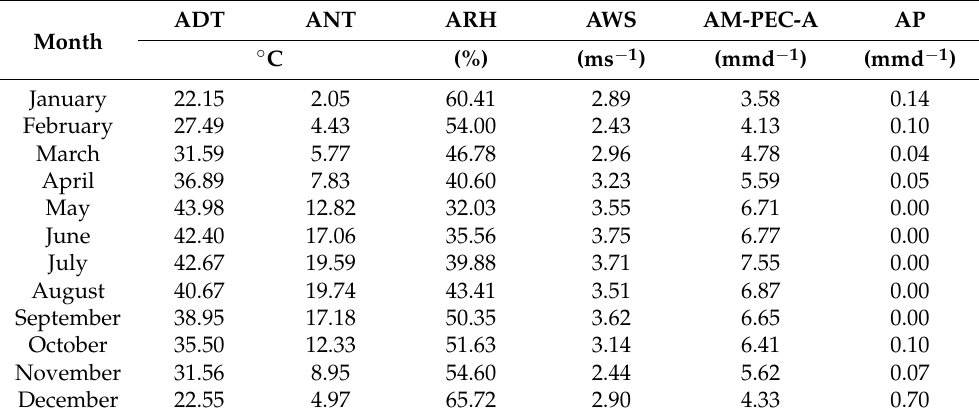
Table 1. Monthly climate averages for Kawm Ushim region, Fayoum, Egypt, during the 2018 and 2019 seasons. ADT ANT ARH AWS AM-PEC-A AP Month ◦